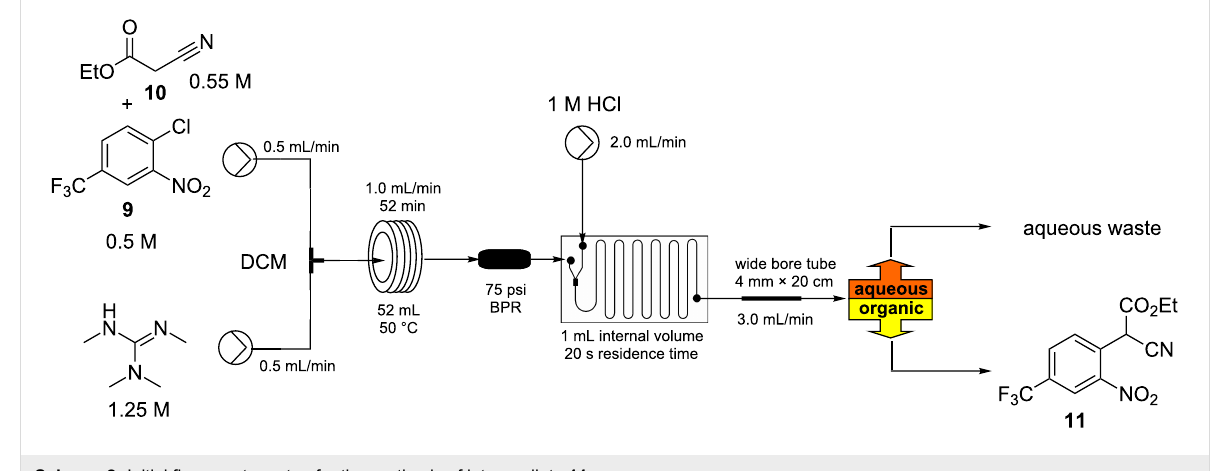
Scheme 2: Initial flow reactor setup for the synthesis of intermediate 11 .